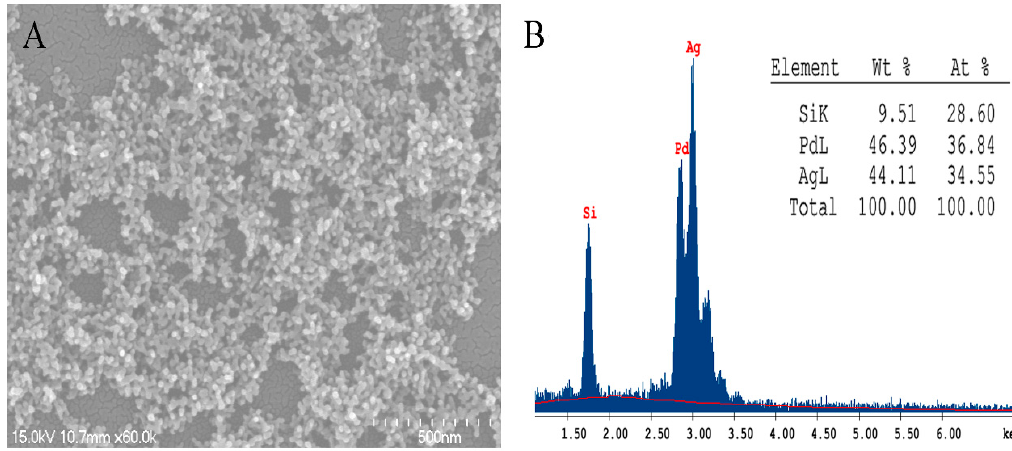
Figure 1. SEM (scanning electron microscope) image of PdAg catalyst ( A ); EDX (energy-dispersive X-ray analyzer) spectrum of PdAg catalyst ( B ).